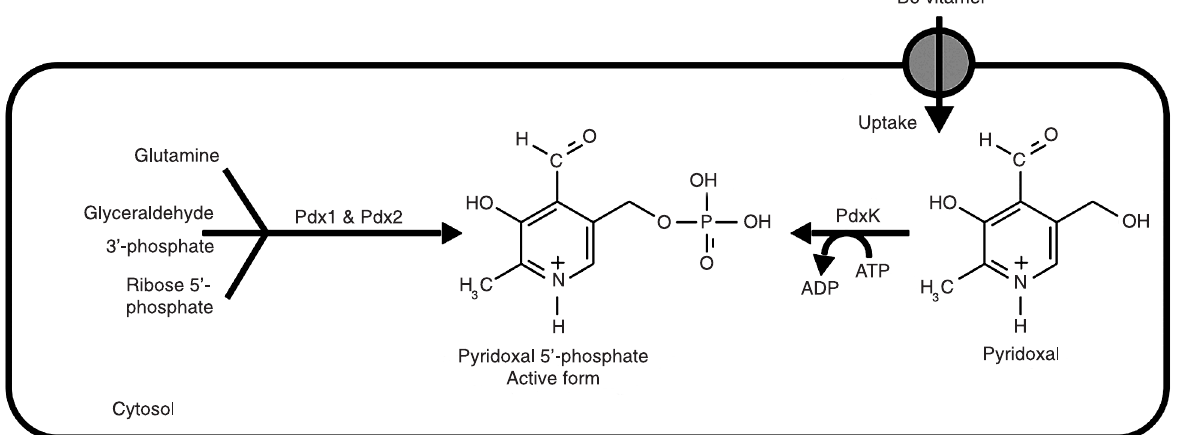
Figure 1. Vitamin B6 biosynthesis in Plasmodium falciparum. For explanation of the abbreviations see